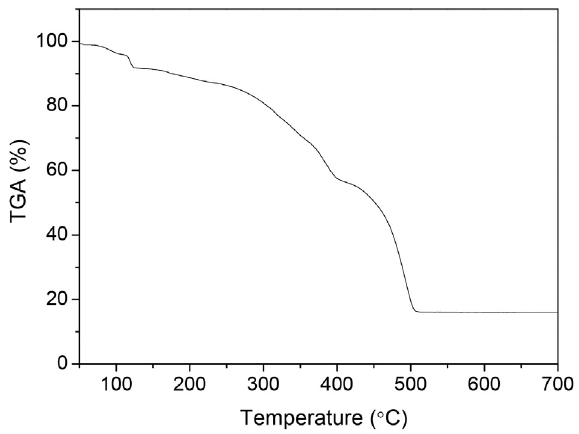
Figure 7. The TGA thermogram of complex 1 in air atmosphere.